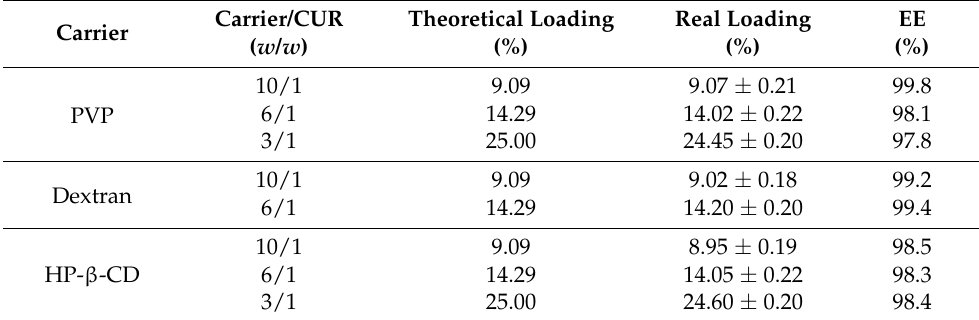
Table 4. CUR loadings and encapsulation efficiency (EE) for the particles obtained by SAA process using the different carriers. Carrier